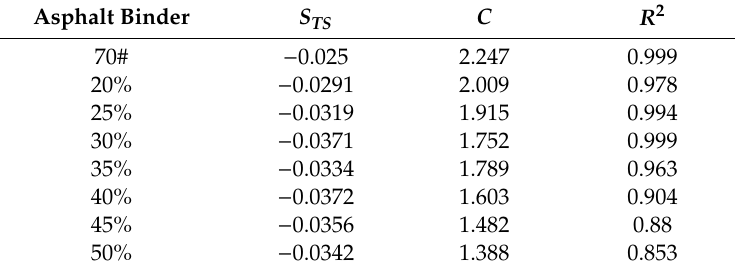
Figure 11. Low-temperature sensitivity of high-content rubberized asphalt. Table 3. Fitting results of low-temperature sensitivity analysis.